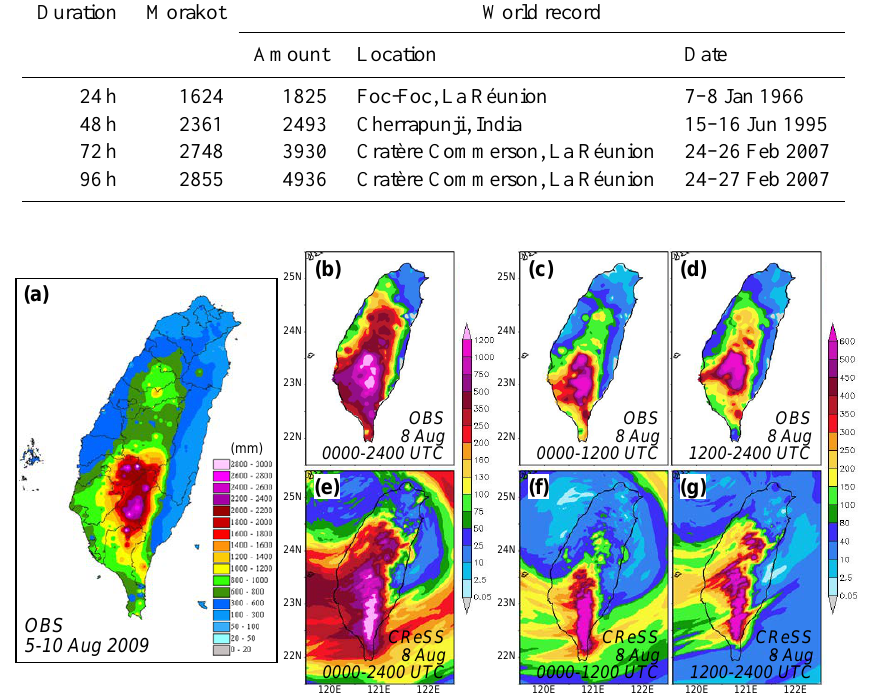
Figure 2. Observed (a) total rainfall distribution (mm) in Taiwan over 5–10 August, (b) daily (00:00–24:00UTC) rainfall distribution on 8 August, and 12h rainfall over (c) 00:00–12:00UTC and (d) 12:00–24:00UTC on 8 August, during Morakot (2009). (e – g) Same as (b – d) except from 1km CReSS model